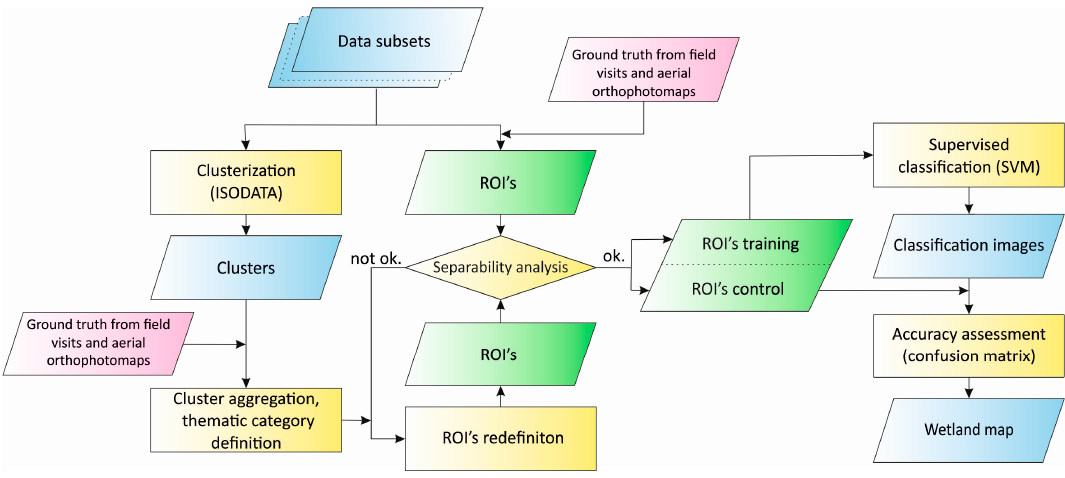
Figure 8. The workflow of the thematic processing of the data subsets.